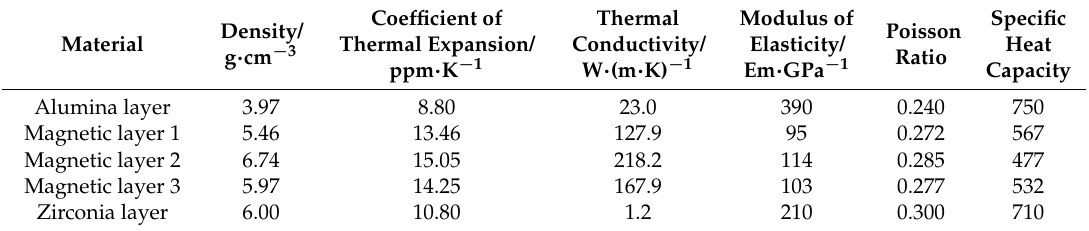
Table 5. Material parameters of the model with a gradient structure.